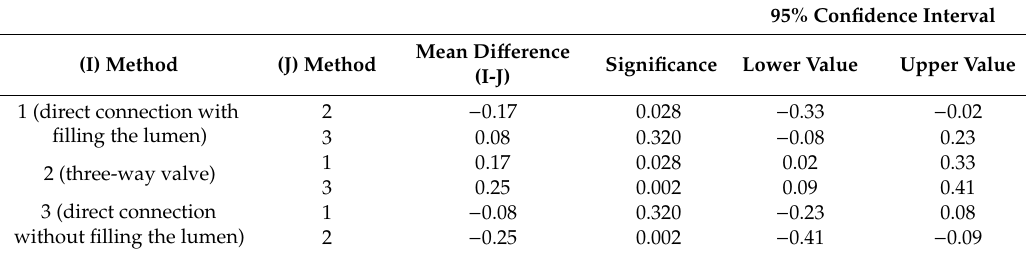
Table 4. Pairwise comparison of the